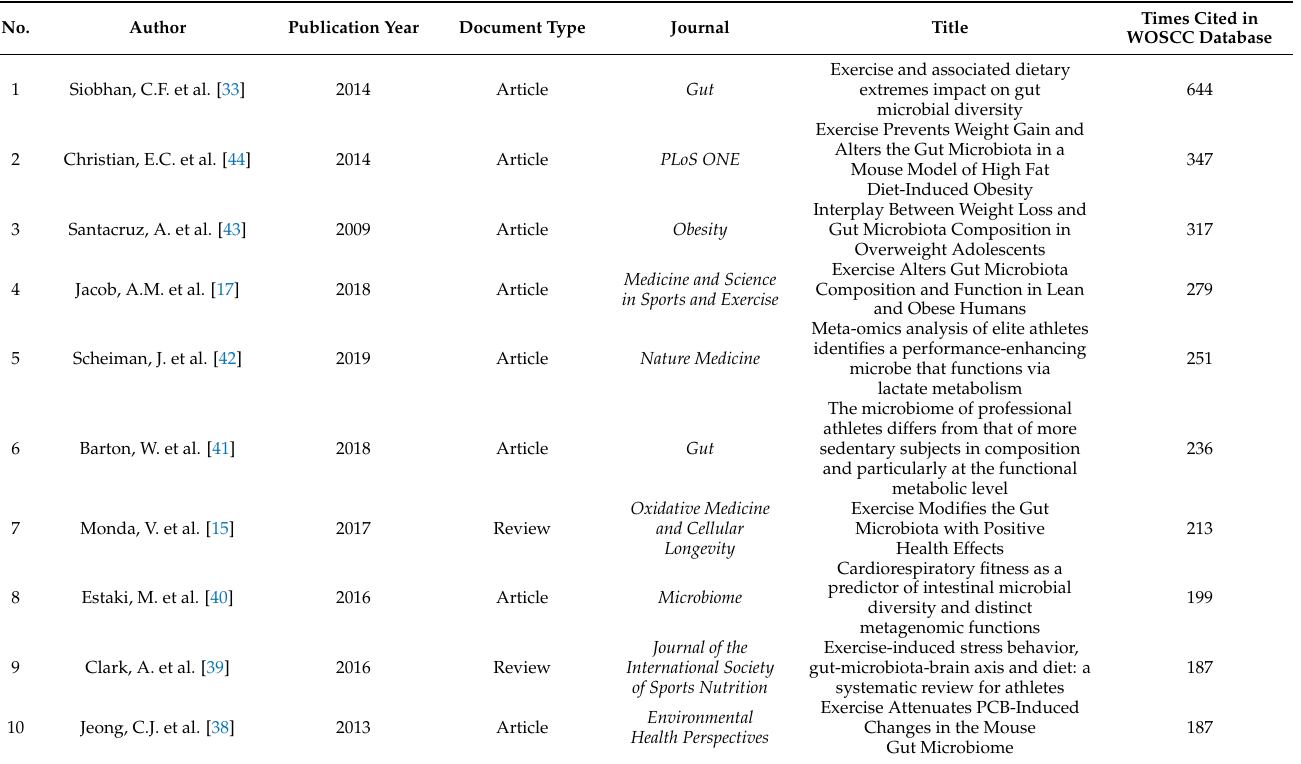
Table 5. The top 10 most cited publications in the field of gut microbiome and